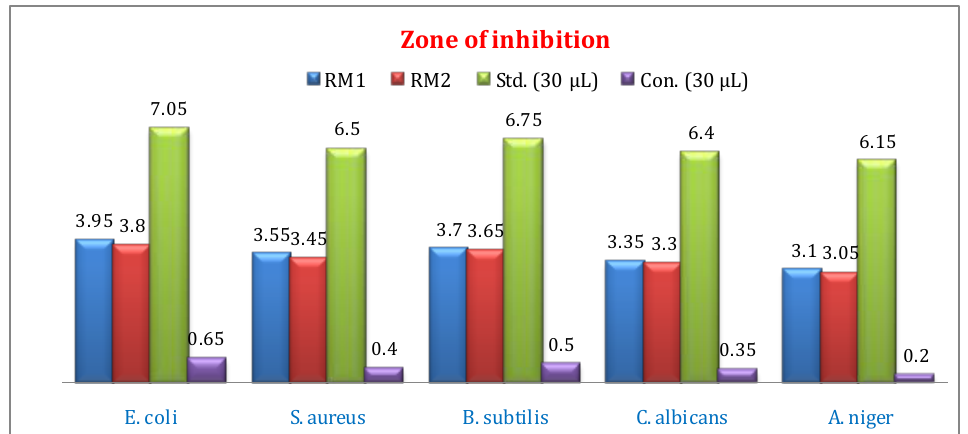
Figure 7. Antibacterial activity of (RM1) Co(II) and (RM2) Ni(II) complexes zone of inhibition and MIC 30 µL.